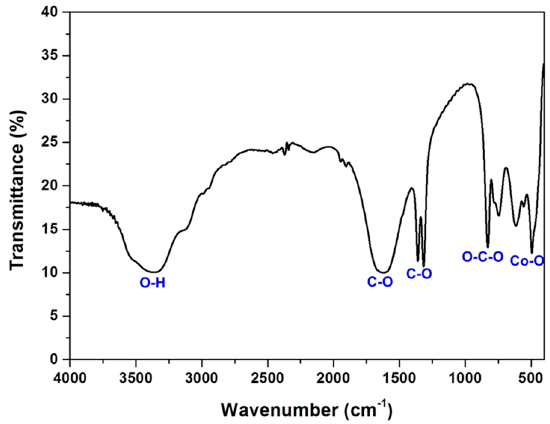
Figure 4. Fourier transform infrared (FT-IR) spectrum of the Co compound resulting from our process.